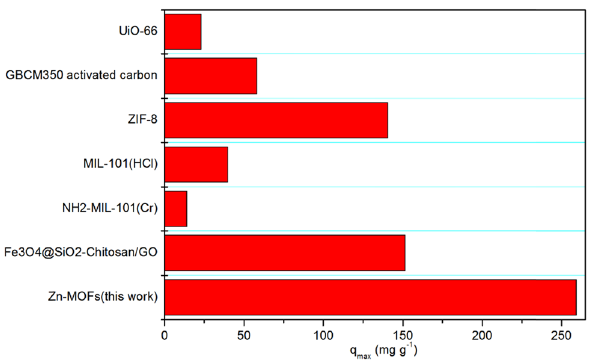
Figure 8: Comparison of the Zn - MOFs adsorbent with other mate - rials on TC